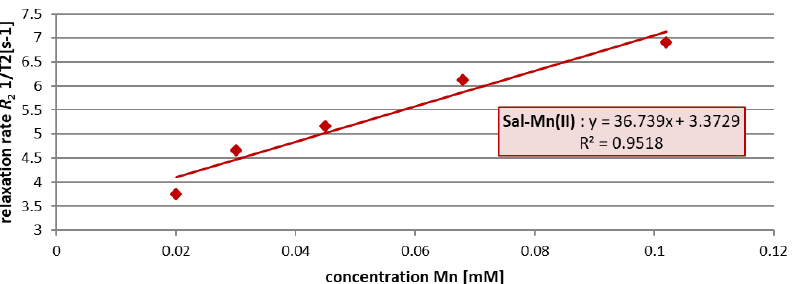
Figure 4. Plots of relaxation rates ( R 1 / R 2 , [1/s]) to concentration (mM) curves for Sal-Gd(III), Sal- Mn(II), and EcN1917 -BGs loaded with both Sal complexes compared to clinically applied gadopente- tate dimeglumine (Magnevist ® , linear, grey line) and gadoteridol (ProHance ® , cyclic, yellow line). For better comparison, one point from the Sal-Gd(III) graph corresponding to 0.33 mM concentration has been omitted. A strong signal increase in MRI using either the non-loaded Sal-Gd(III) and Sal-Mn(II) or the loaded complexes was shown, comparable with or superior to the effect caused by the clinically most applied CAs, gadopentetate dimeglumine and gadoteridol. The Sal-Gd(III) compound caused a predominant T 1 effect only; thus, just the R 1 dependence with increasing concentration is